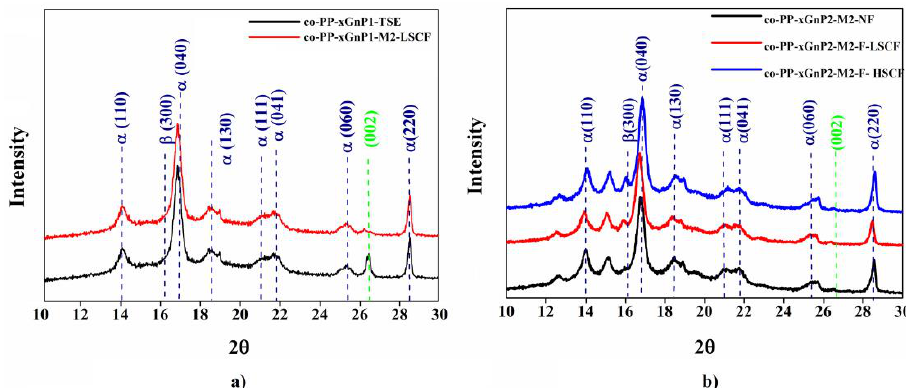
Figure 9. Comparative diffraction pattern of representative nanocomposites. ( a ) Neat and foamed samples with 1 wt % xGnP via Method 1 with low SCF amount; ( b ) neat and foamed sample with 2 wt % xGnP via Method 2 with low and high SCF amount. xGnP: graphene platelet. Additionally, the disappearing of the peak at 2θ = 28.6° is attributed to the full exfo- liation of the xGnP layers. For further investigation, the skin layer of samples prepared by